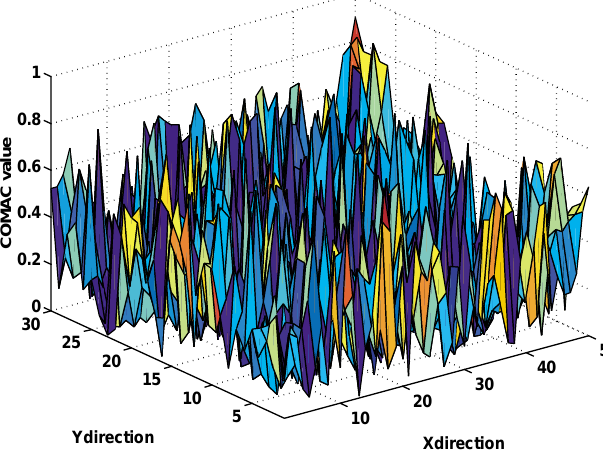
Fig. 5. COMAC values between damaged and undamaged states, for LSCE-LSFD mode